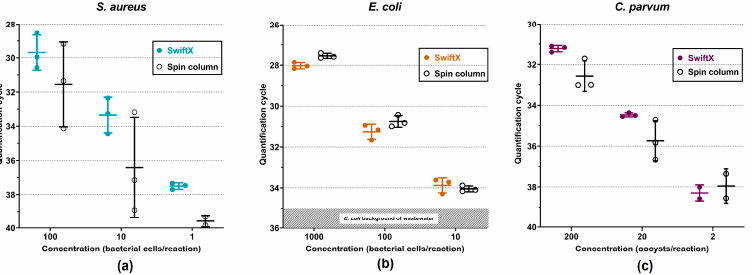
Figure 5. Determination of limit of detection in spiked wastewater samples extracted by the most efficient extraction procedures for S. aureus ( a ), E. coli ( b ) and C. parvum ( c ). SwiftX protocol was combined with proteinase K and a bead-beating step for S. aureus and E. coli , whereas for C. parvum , the proteinase K and SwiftX protocol was applied. Ten-fold serial dilutions of spiked wastewater were screened. After extraction, the quantification cycle of each dilution was measured using real-time PCR. All results were compared to a spin column reference method. Down to one bacterial cell of S. aureus per reaction was detected ( a ), while the threshold was ten with E. coli ( b ). For C. parvum , the limit of detection was two oocysts per reaction ( c ). Because of the E. coli pre-existence in wastewater, the shaded zone in ( b ) represents the background values.